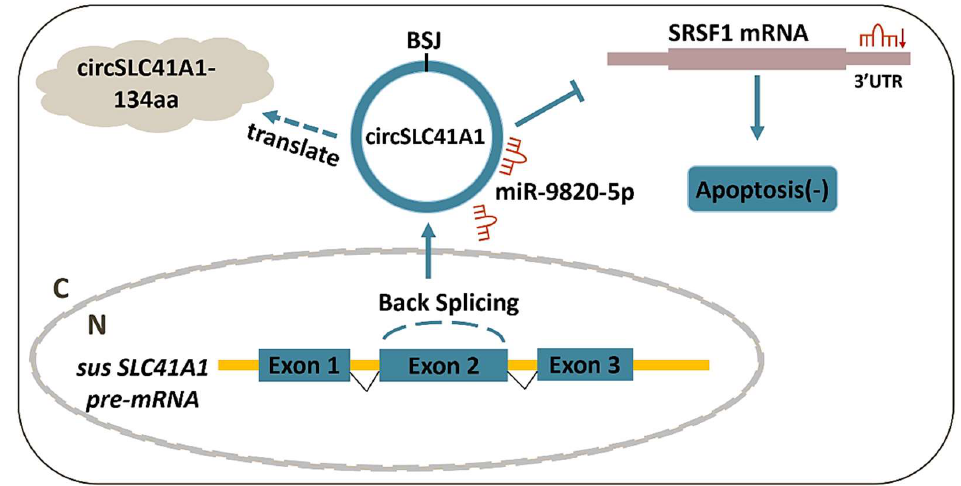
Figure 8. Schematic diagram of circSLC41A1 functions in GC apoptosis. circSLC41A1 can function by competing with SRSF1 mRNA for miR-9820-5p interactions, thereby alleviating the post-tran- scriptional repression of SRSF1 and thus resisting GC apoptosis and follicular atresia. circSLC41A1 also had the potential to encode small circSLC41A1-134aa peptides.